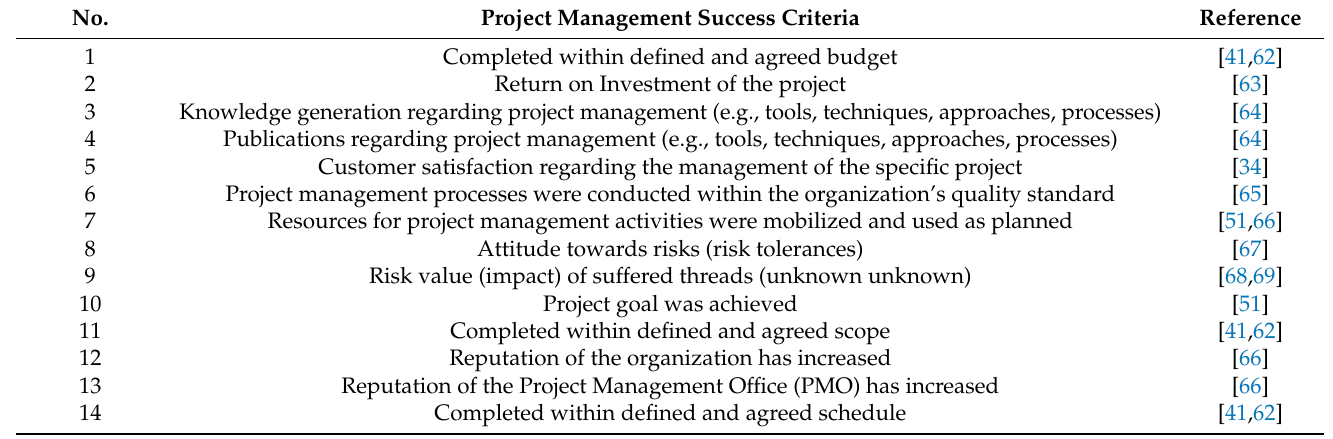
Table 1. Project Management Success Criteria.